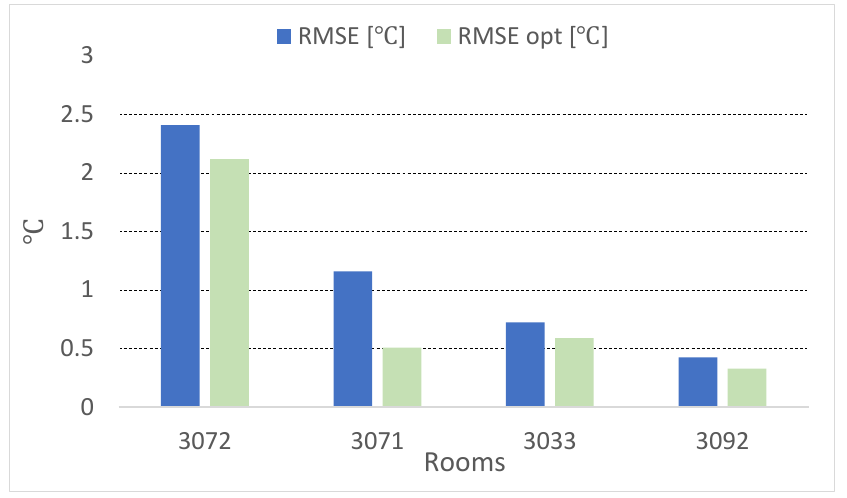
model. optimized model.